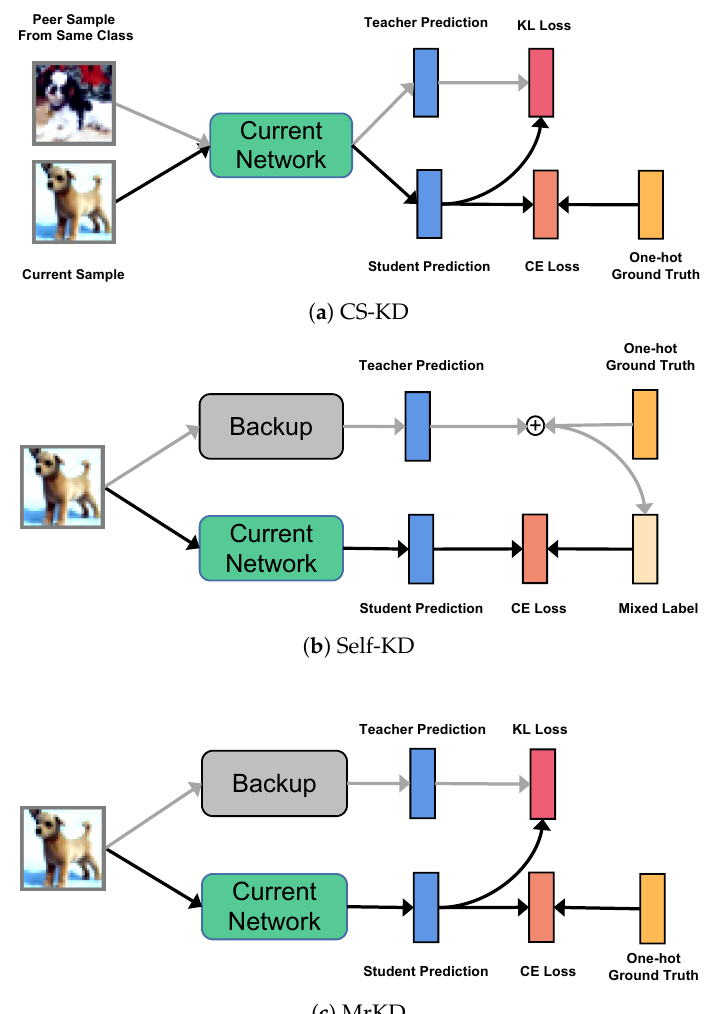
Figure 2. Simplified graphical illustration for different self-knowledge distillation methods. ( a ) Class- wise self-Knowledge Distillation [19]; ( b ) self-Knowledge Distillation [21]; ( c ) memory replay Knowl- edge